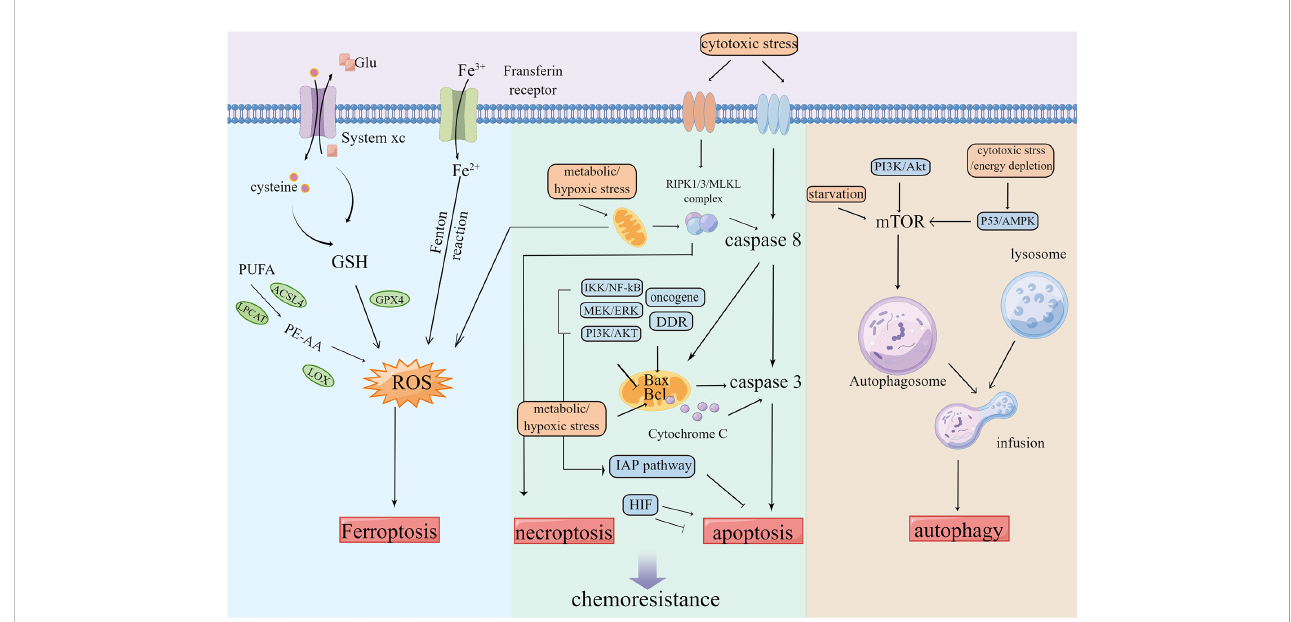
FIGURE 3 Tumors keep their sustained growth, metastasis and gain chemoresistance by escaping cell death such as ferroptosis, apoptosis and autophagy